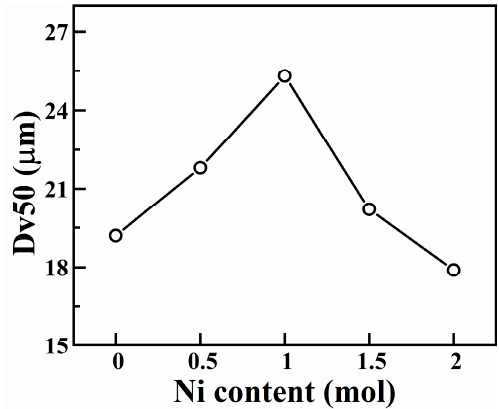
Figure 8. Dv50 of CoCrCuFeMnNi x HEAPs after 50 h ball milling.